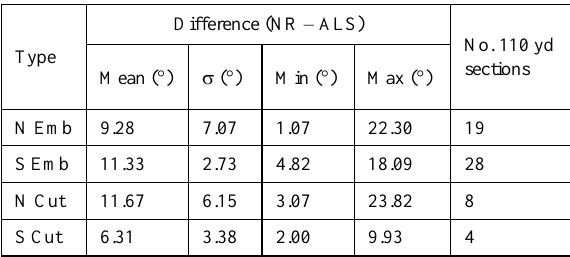
Table 3. Difference statistics for ALS-derived slope gradients compared to those evaluated by NR.